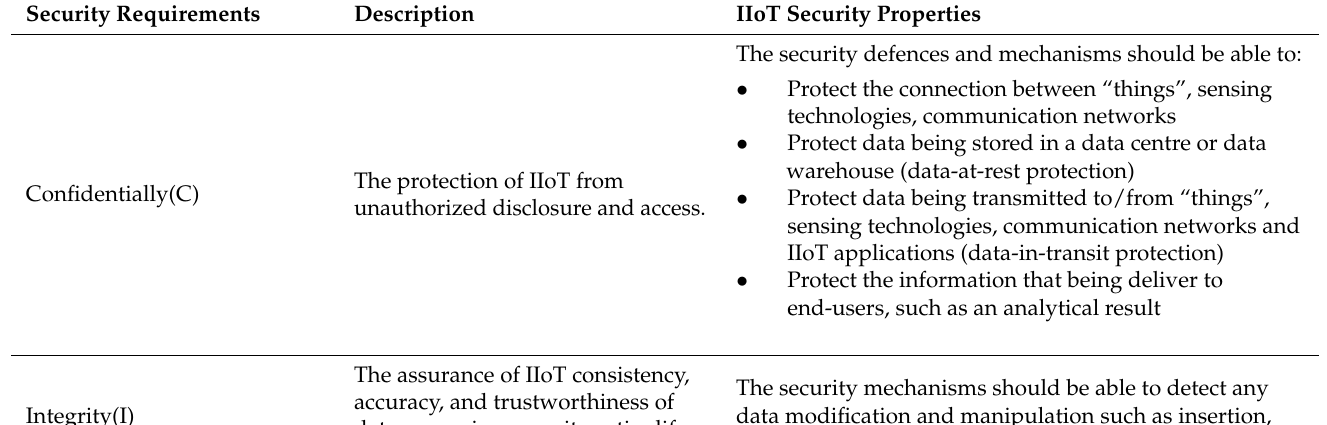
Table 3. CIA+ model of IIoT